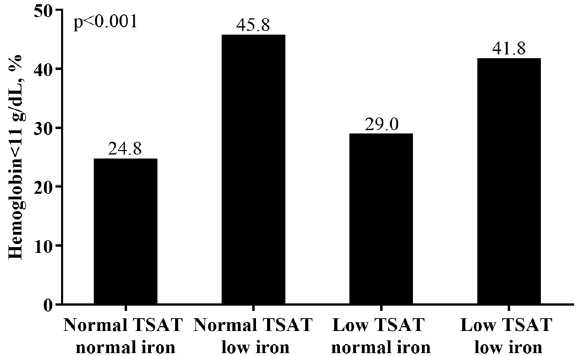
Figure 1. Anemia divided by TSAT and serum iron.